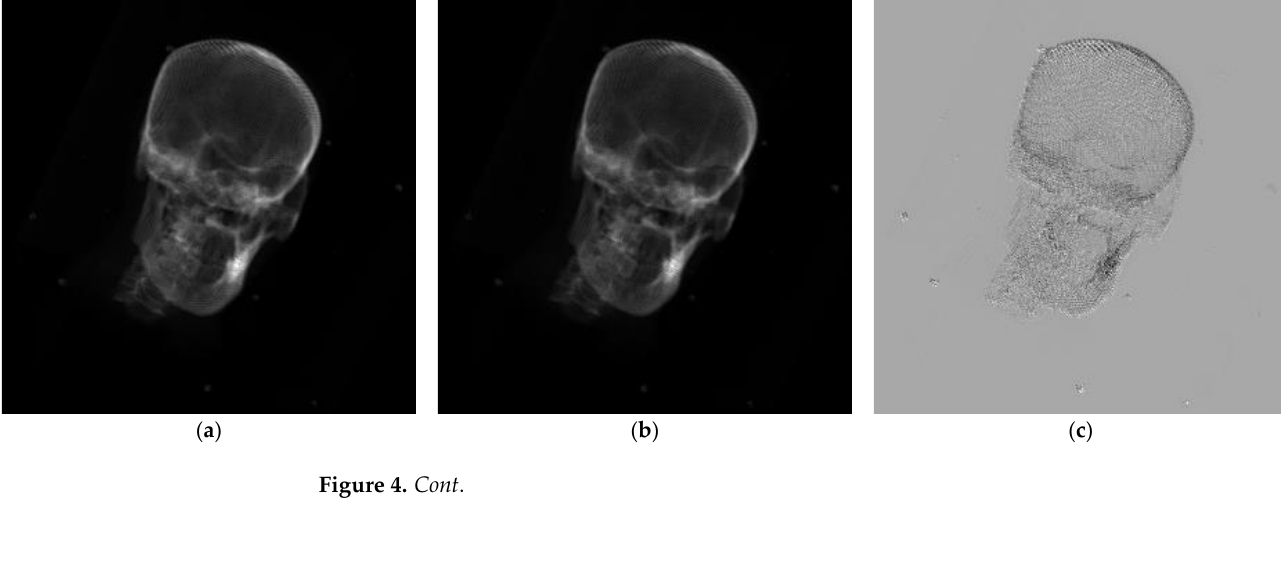
Figure 3. DRR image at the initial value.